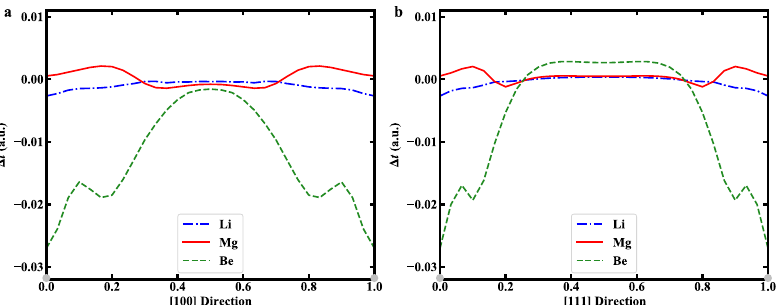
Fig. 4 Kinetic energy differences in SC structure for Li, Mg, and Be systems. a The calculated differences along [100] direction. b The calculated differences along [111] direction. Note that Δ t ð r Þ (cid:3) t WT s ½ ρ KS (cid:2)ð r Þ (cid:5) t KS s ð r Þ .